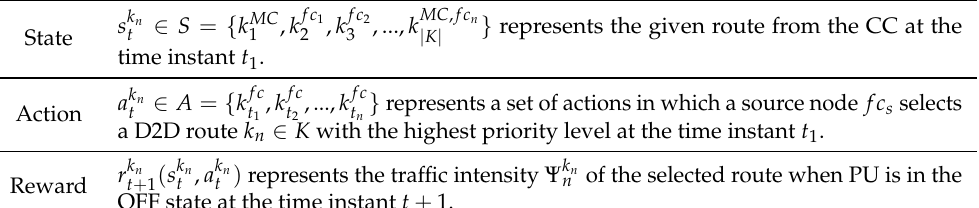
Table 1. The RL model for the route selection embedded in the BS of the small cell and its correspond- ing nodes in the data plane.